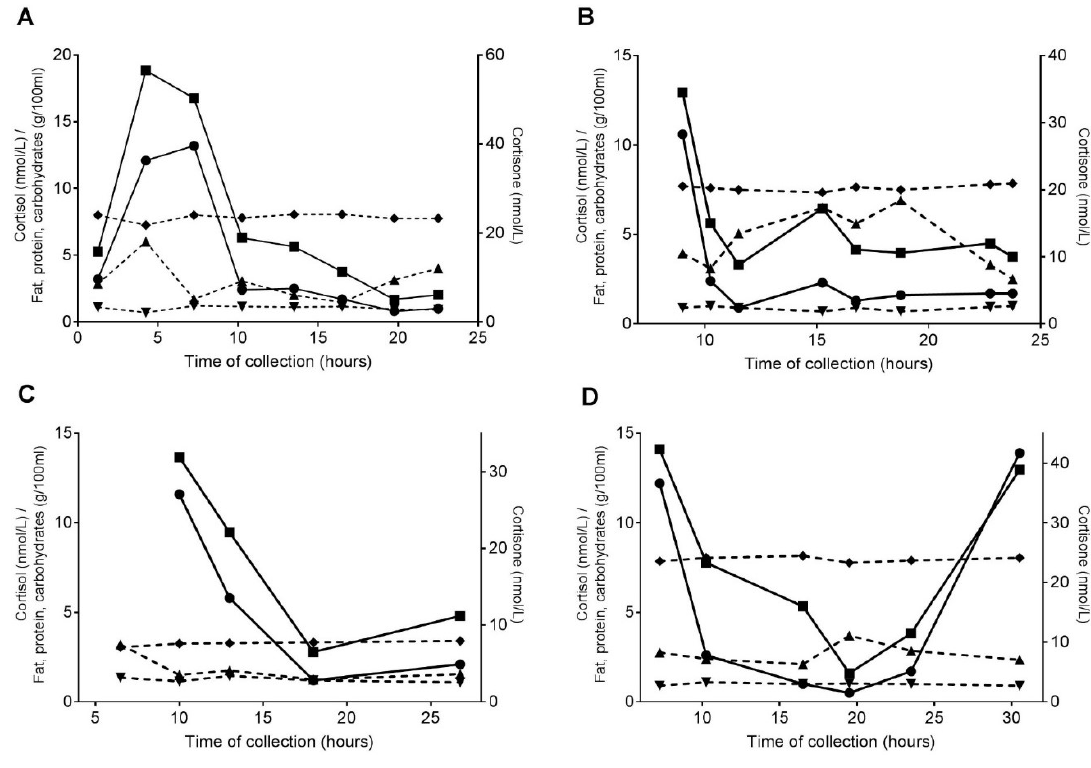
Figure 1. ( A – D ) The individual plots for milk cortisol ( ● ), cortisone ( (cid:3161) ), fat ( ▲ ), protein ( ▼ ), and carbohydrate ( ◆ ) concentrations for four mothers. Left y-axis: cortisol concentrations (nmol/L) and milk macronutrient concentrations (g / 100 mL); right y-axis: cortisone concentrations (nmol / L); x-axis: time of collection (hours); continuous lines: GC concentrations; and dotted lines: macronutrient